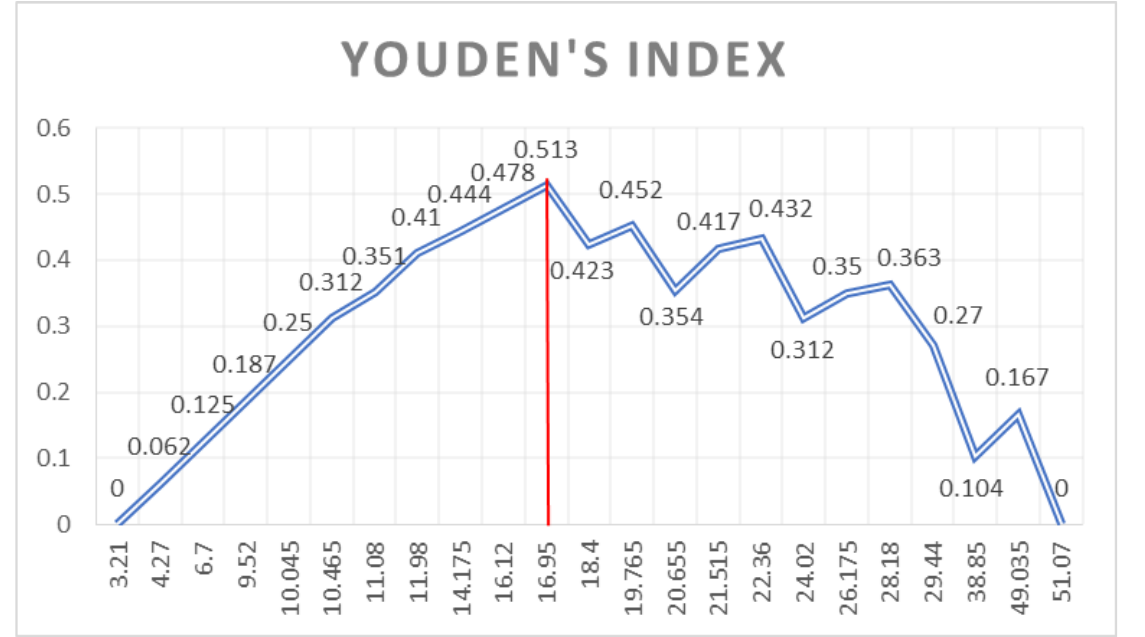
Figure 5. Youden’s index of the AML length ROC curve.